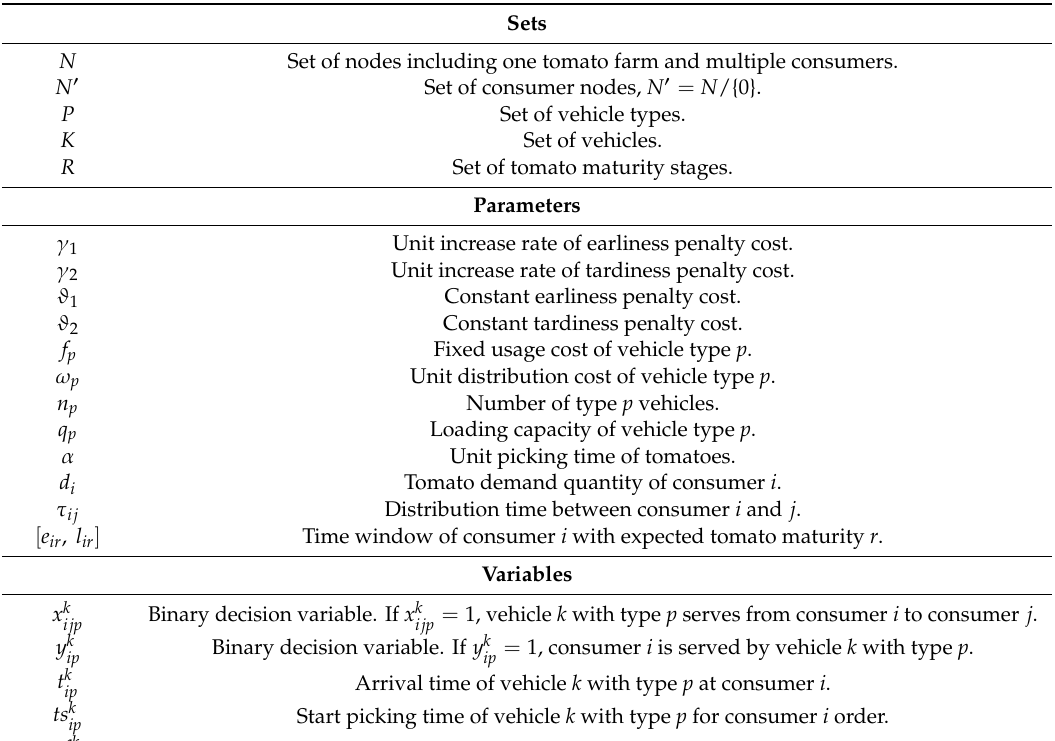
Table A1. Notation